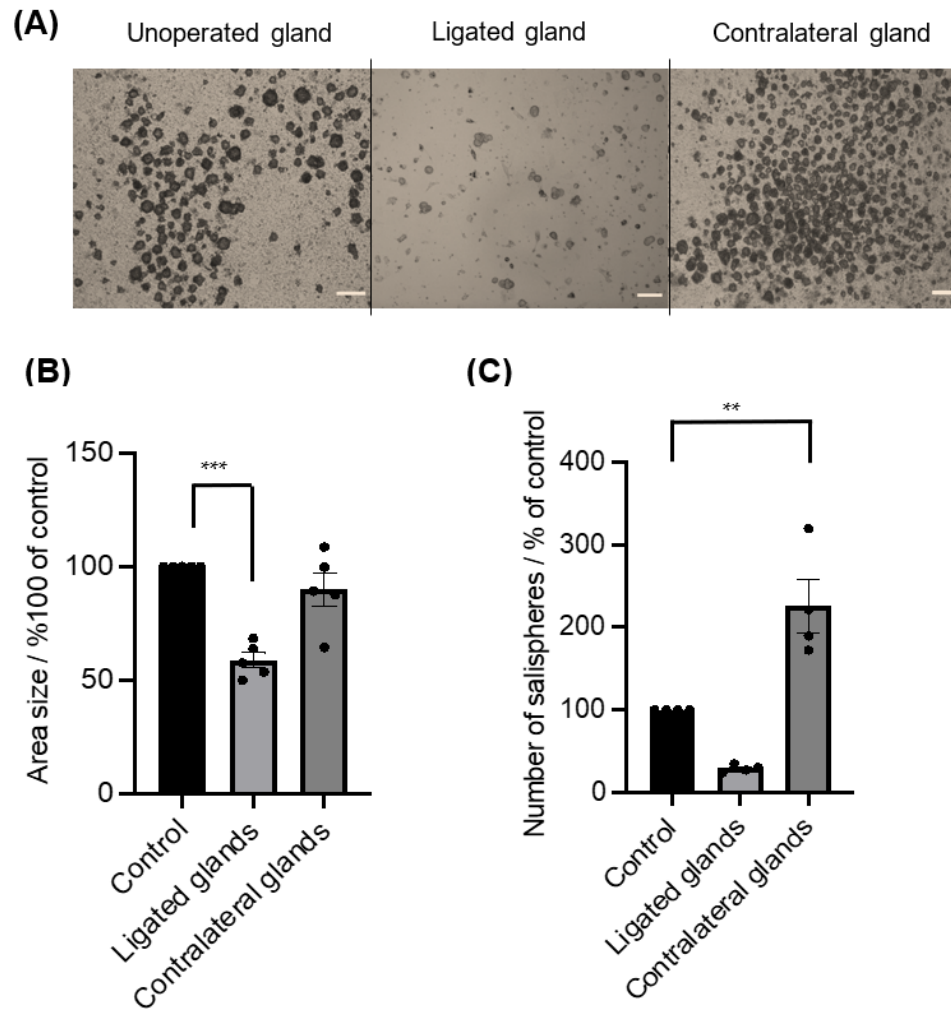
Figure 5. ( A ) Images of grown salispheres at day 4 of culture from unoperated glands, ligated glands, and contralateral glands (scale bar = 20 um). ( B ) The area size of the salispheres was significantly reduced in cultured salispheres from ligated glands (*** p < 0.0005), whereas there were no significant differences between cultured salispheres from unoperated glands and contralateral glands ( p = 0.3251). ( C ) The number of salispheres from ligated glands was reduced, and the number of cultured salispheres from the contralateral glands was considerably higher compared to cultured salispheres from unoperated glands (** p < 0.005). Data are expressed as mean ± S.E.M ( n = 5).